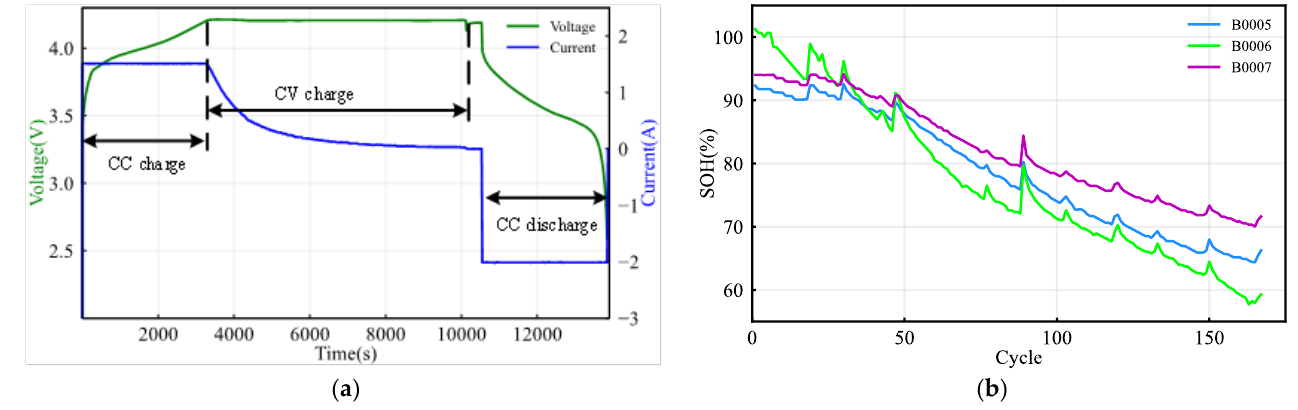
Figure 1. ( a ) Battery terminal voltage and charge/discharge current during one cycle; ( b ) the curves of degradation capacity.